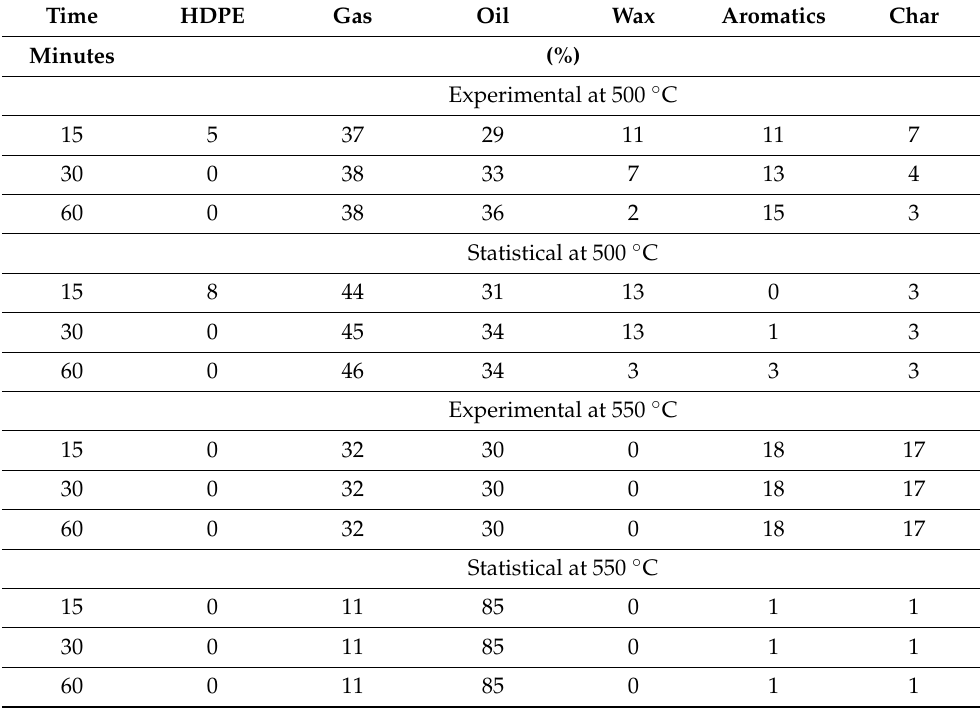
Table 6. The time-dependent conversion of HDPE into the final products. Time HDPE Gas Oil Wax Aromatics Char